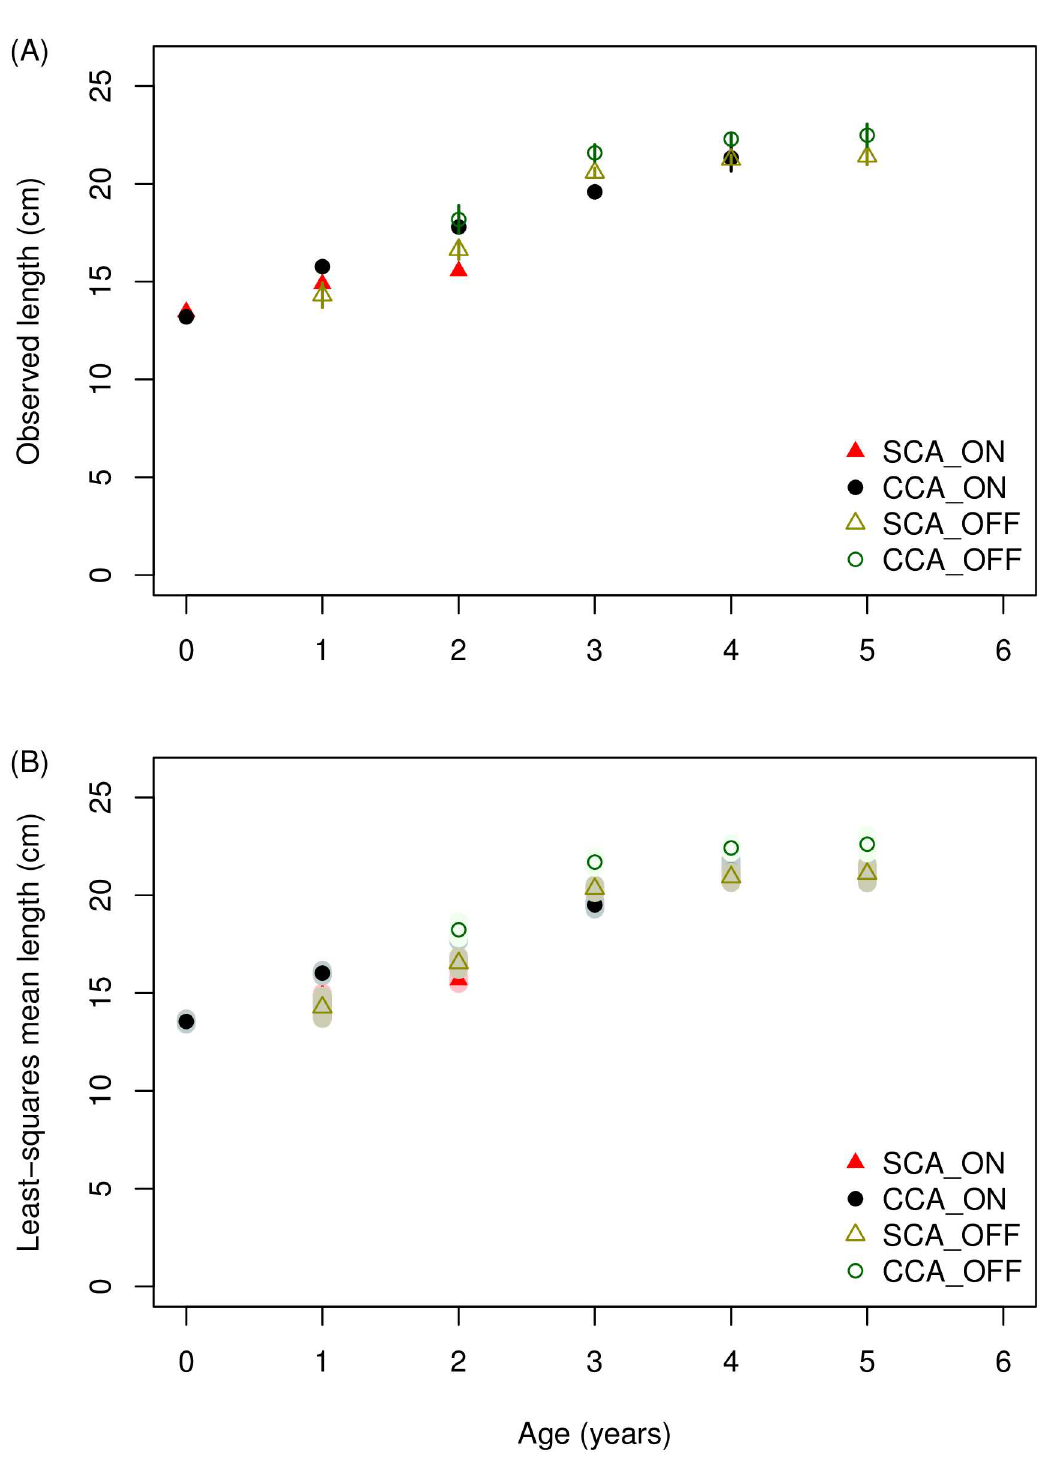
Fig 6. Observed mean length-at-age and least-squares mean length-at-age for quarter 2 (April-June, 2004– 2010). (A) Observed mean length-at-age; and (B) least-squares mean length-at-age from the spawningareas of SouthernCalifornia onshore( ▲ ), SouthernCaliforniaoffshore ( Δ ), central Californiaonshore( ● ) and central California offshore ( ○ ), where the error bars in the upper panel indicatethe 95% confidenceintervalsof the observations and shadedareas represent 95% confidence intervals of the